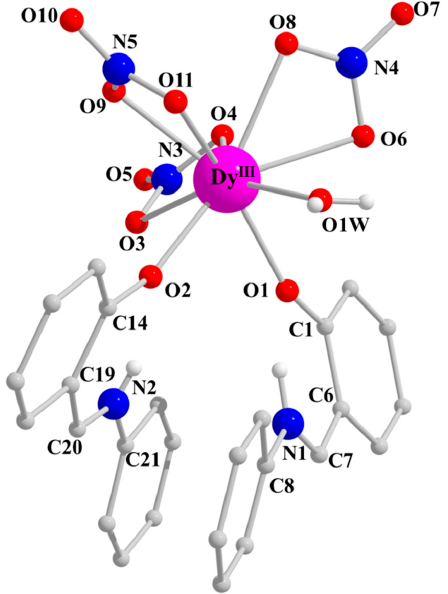
Figure 2. Partially labelled plot of the structure of the molecule [Dy(NO 3 ) 3 (salanH) 2 (H 2 O)] that is present in the crystal structure of complex 7 ·MeCN_Dy.